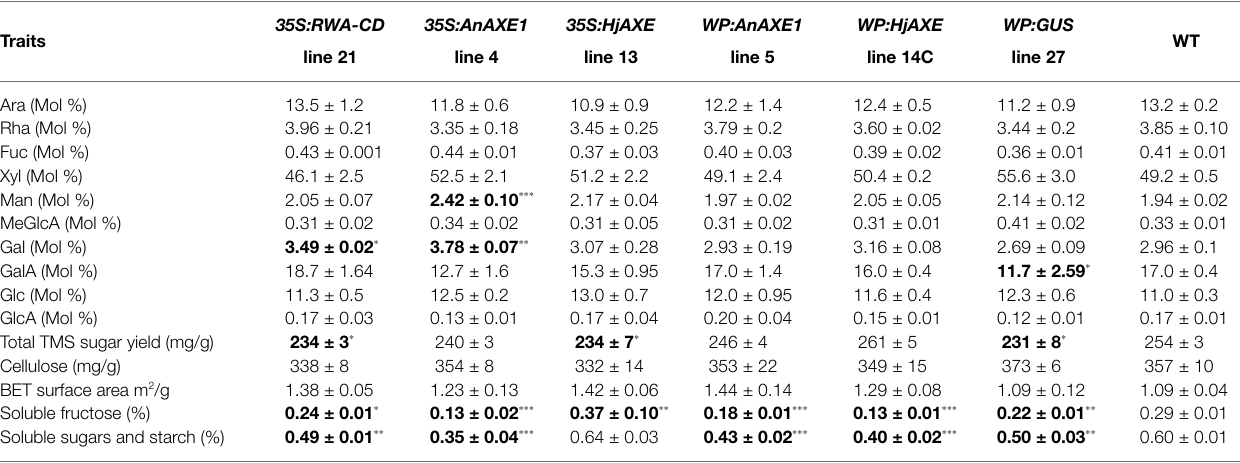
TABLE 4 | Wood traits of selected lines grown in the field.